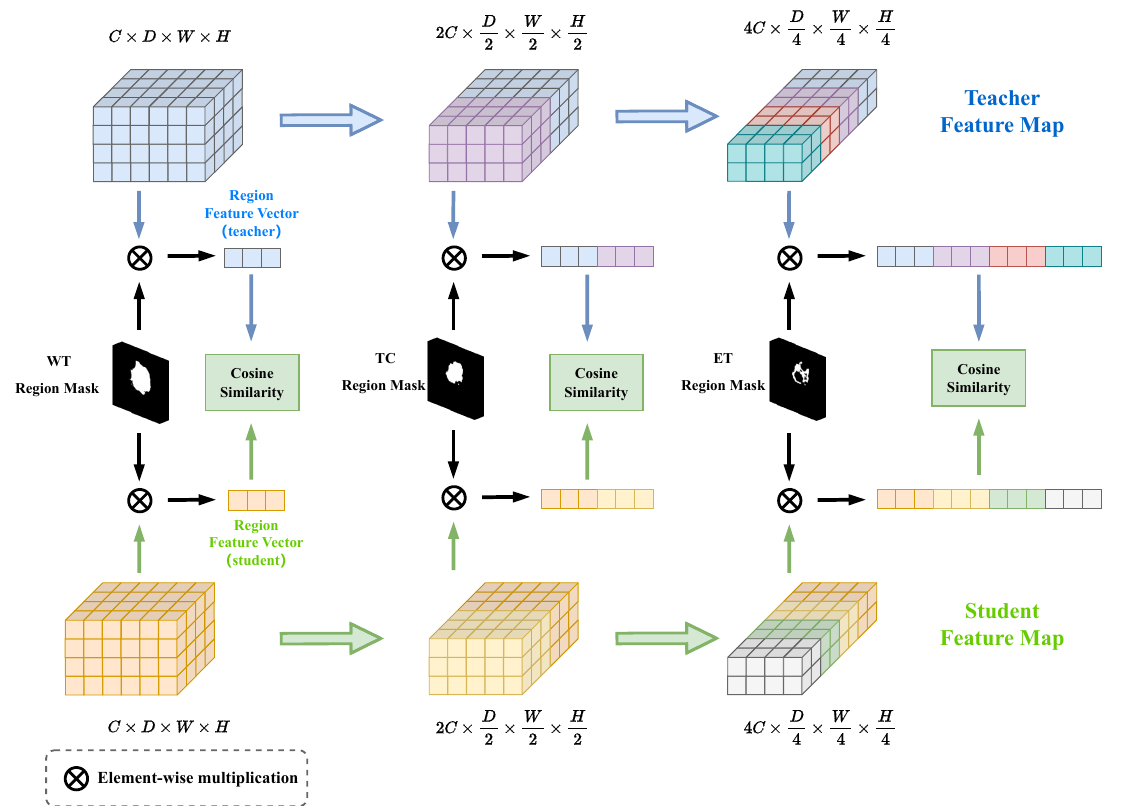
Figure 3. The presentation of the Cascade Region Attention Distillation (CRAD) module. The CRAD module takes in multilayered feature maps from the teacher and student models as input and then multiplies them with the corresponding label masks to obtain the regional feature vectors. The cascade regional distillation loss is obtained by calculating the cosine similarity between the regional feature vectors of teachers and students in the